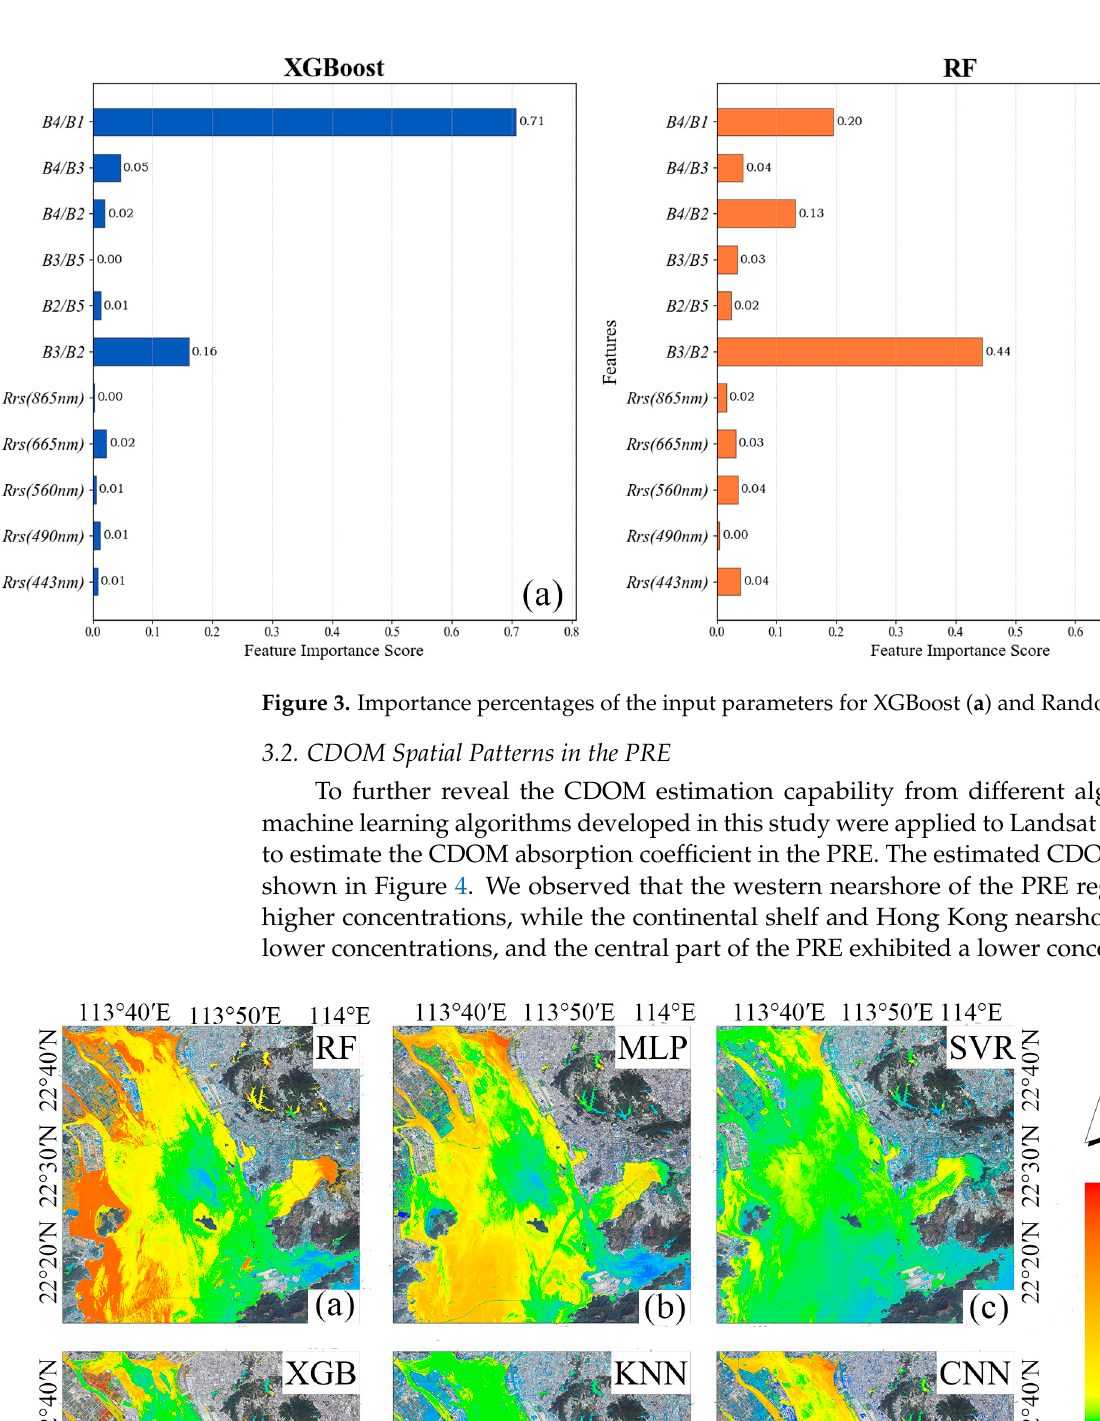
10 of 18 Table 2. Validation results of the six machine learning algorithms determined from the test da- taset.